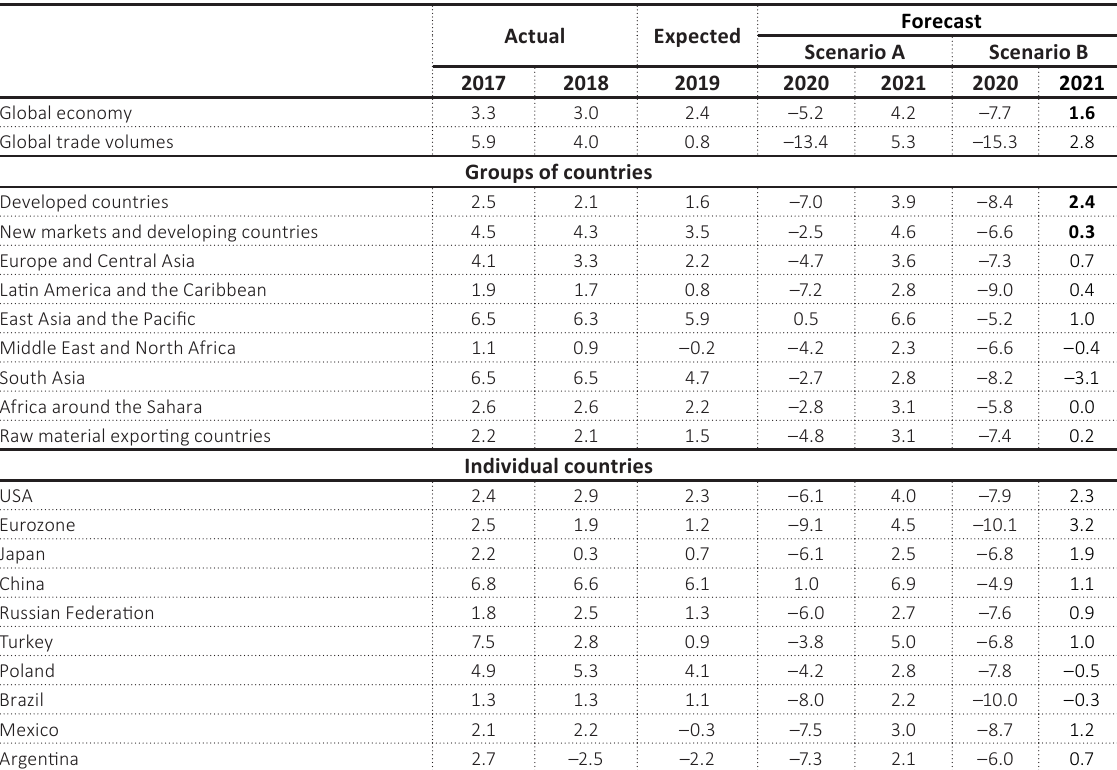
Source: Compiled according to the World Bank